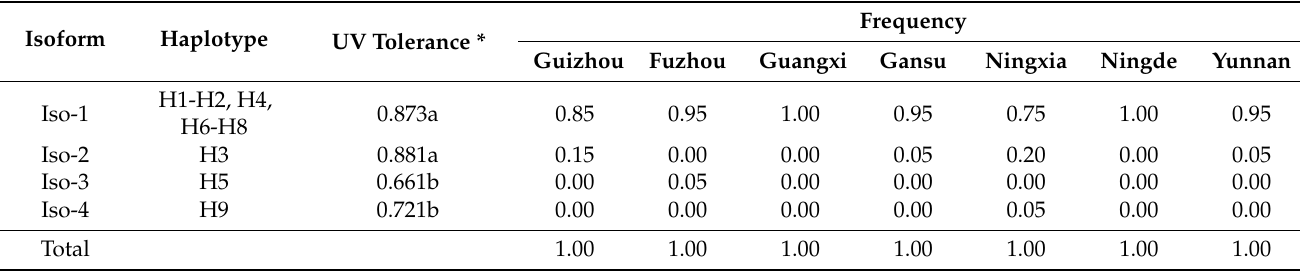
Table 4. Frequency and UV tolerance of deduced isoforms in the seven Phytophthora infestans pop- ulations sampled from China.